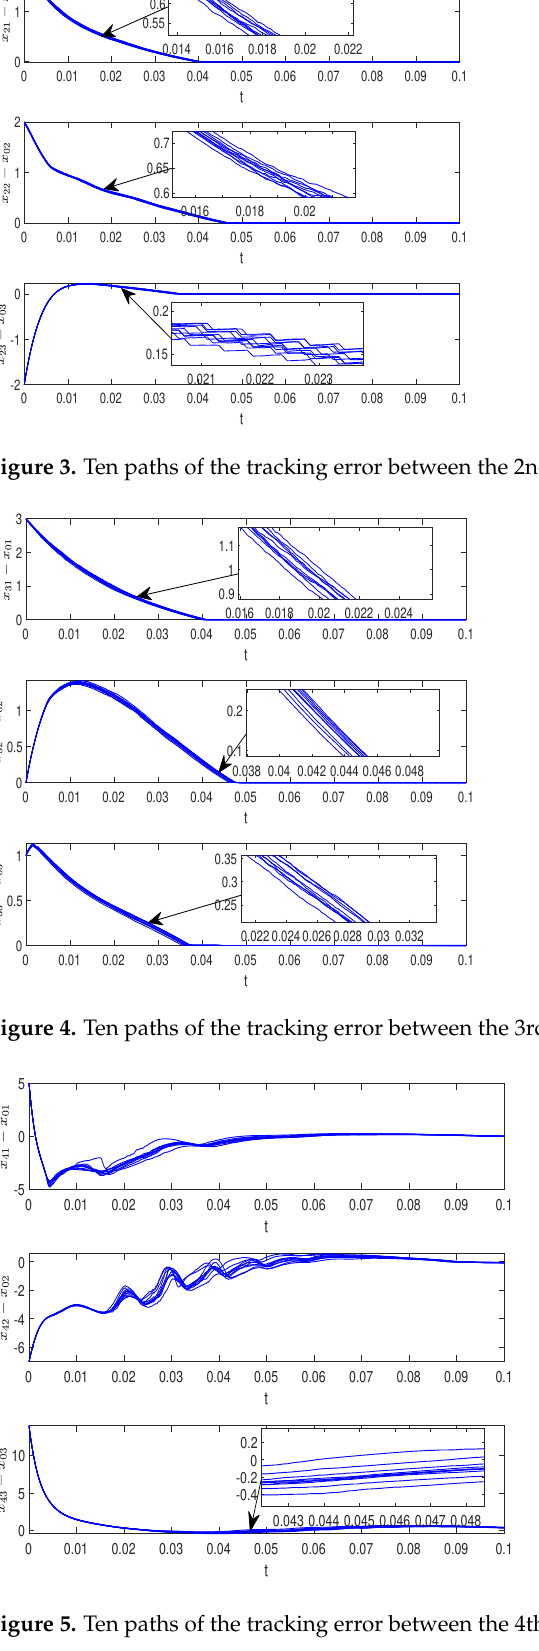
Fig.5. 10 paths of the tracking error between the 4-th subchain and the leader with protocol (4.2).